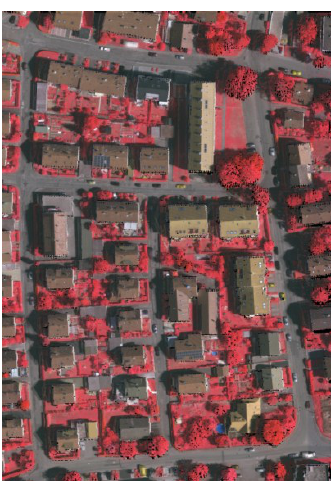
Figure 6. Generated true ortho photo for the second area